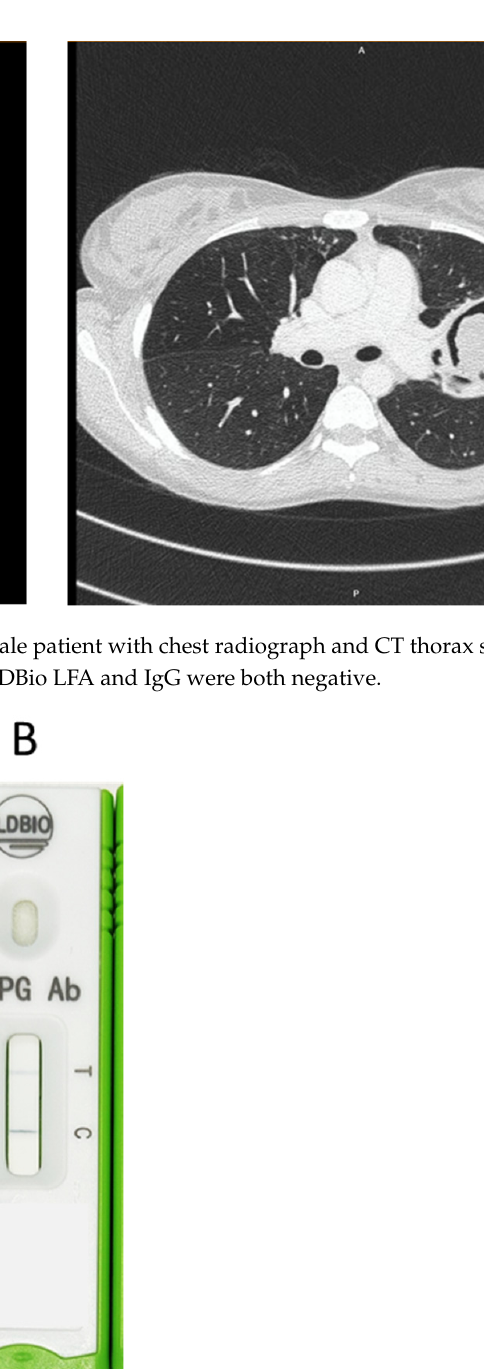
Figure 3. Pictorial representation of LDBio assay results: ( A ) negative, ( B ) positive.